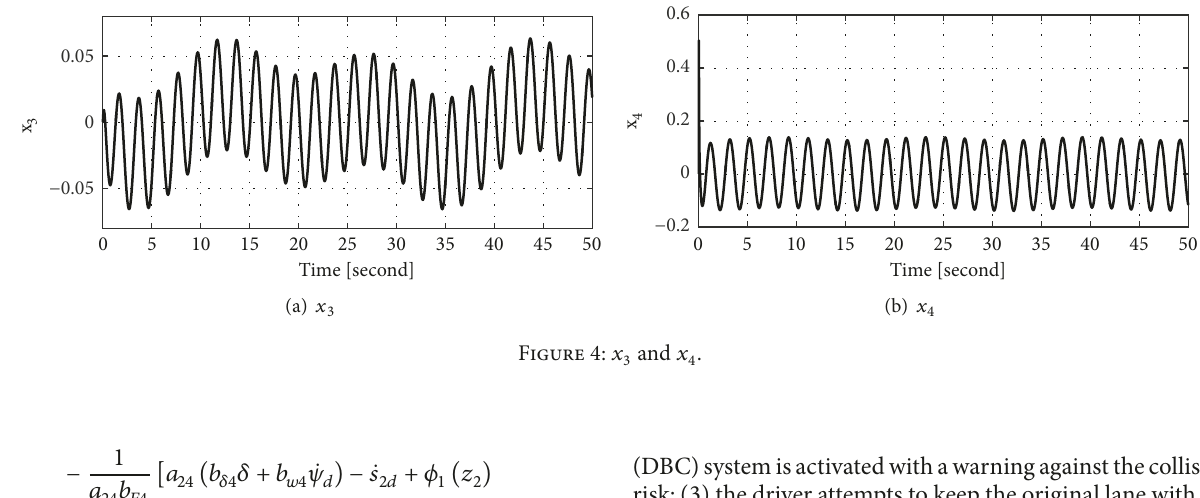
Figure 4: 𝑥 3 and 𝑥 4